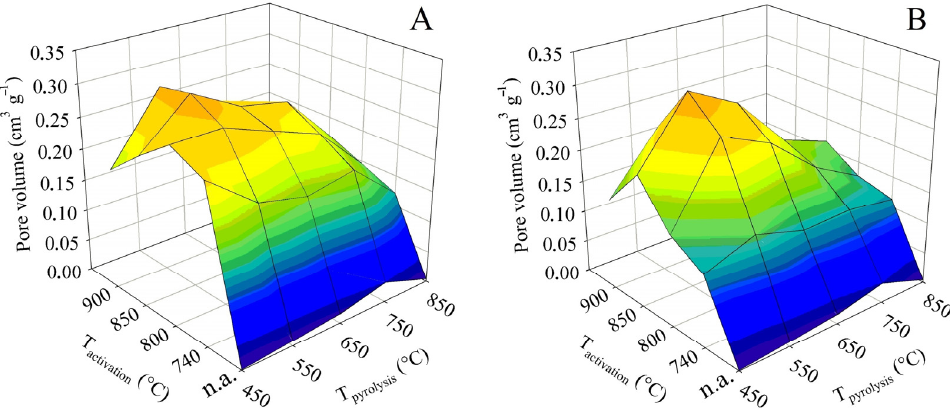
Figure 7. Changes in the volume of the pores with the diameter of <6 nm in dependence on pyrolysis and activation conditions for series ( A , B